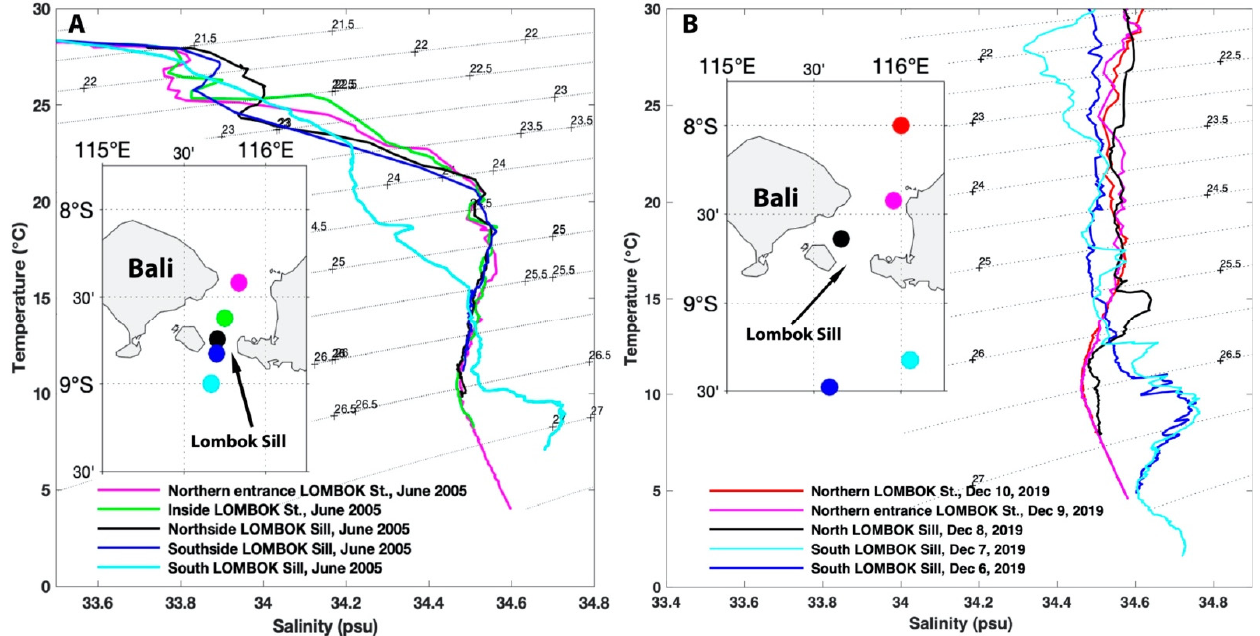
Figure 4. ( A ) Temperature-Salinity diagram of the evolution of water masses from north of Lombok Strait through Lombok Strait into the Indian Ocean taken in ( A ) June 2005, representing southeast monsoon and ( B ) December 2019, representing northwest monsoon.